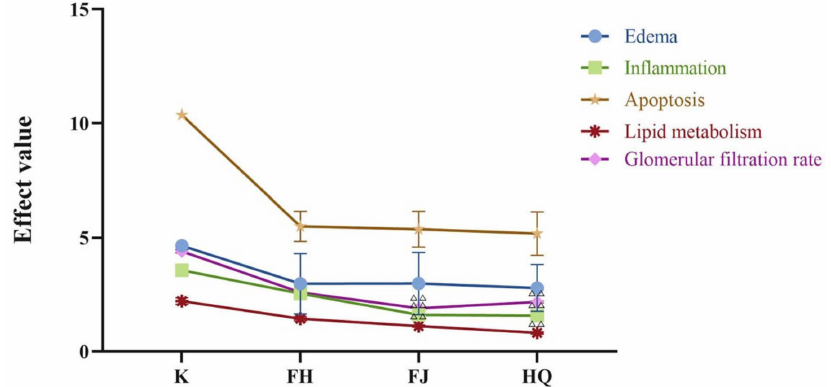
Figure 5. Effects of FJ, HQ, and FH on lipid metabolism, glomerular filtration rate, edema, and inflammatory cell apoptosis in rats with nephrotic syndrome. Note: Compared with FH group, (cid:52)(cid:52) p < 0.01.